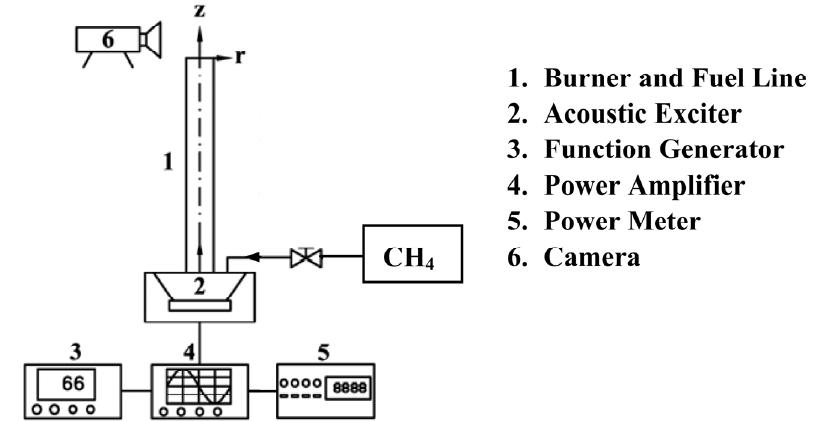
Figure 1. Schematic of jet flow system with acoustic